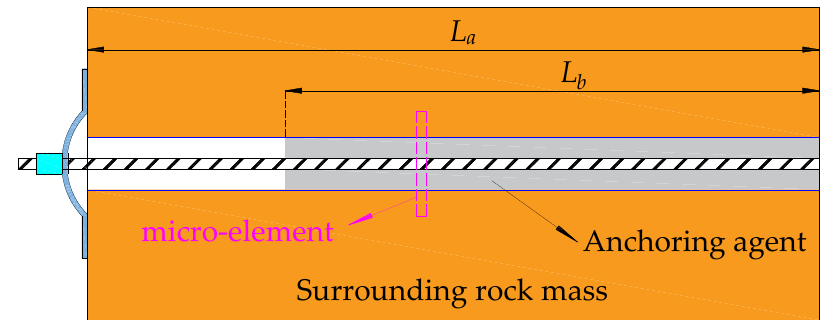
Figure 2. Lengthened anchoring and micro-element sampling of bolts.